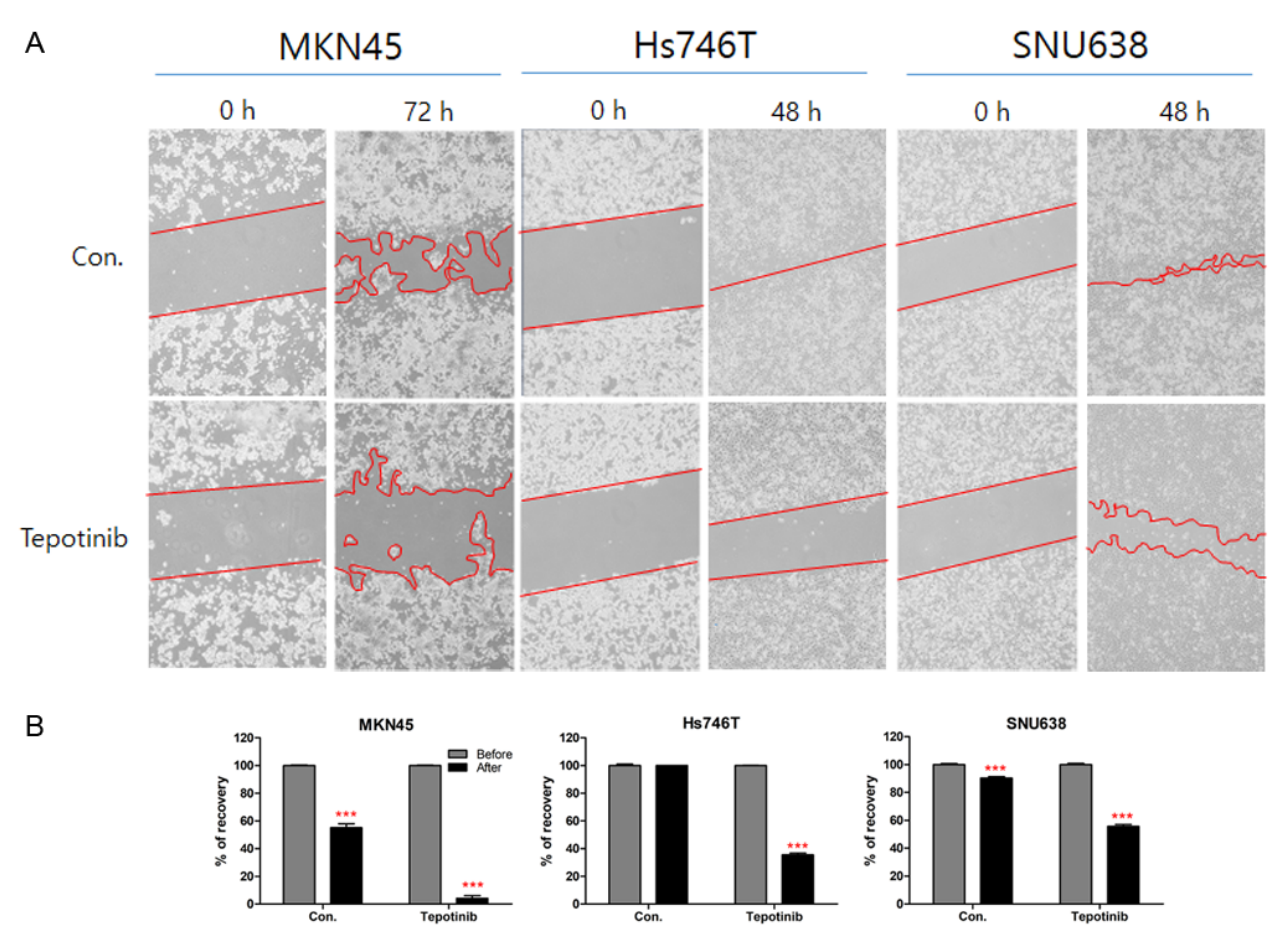
Figure 6. Effects of tepotinib on cell migration in GC cells. ( A ) A wound-healing assay was used to assess the effect of tepotinib on the migration ability of MKN45, Hs746T, and SNU638 cell lines. Hs746T, MKN45, and SNU638 cell lines were treated with 1 µM tepotinib for 48–72 h. ( B ) Using the image J for wounded area analysis. Con, non-treated control cells. *** p < 0.001 compared with the control group.